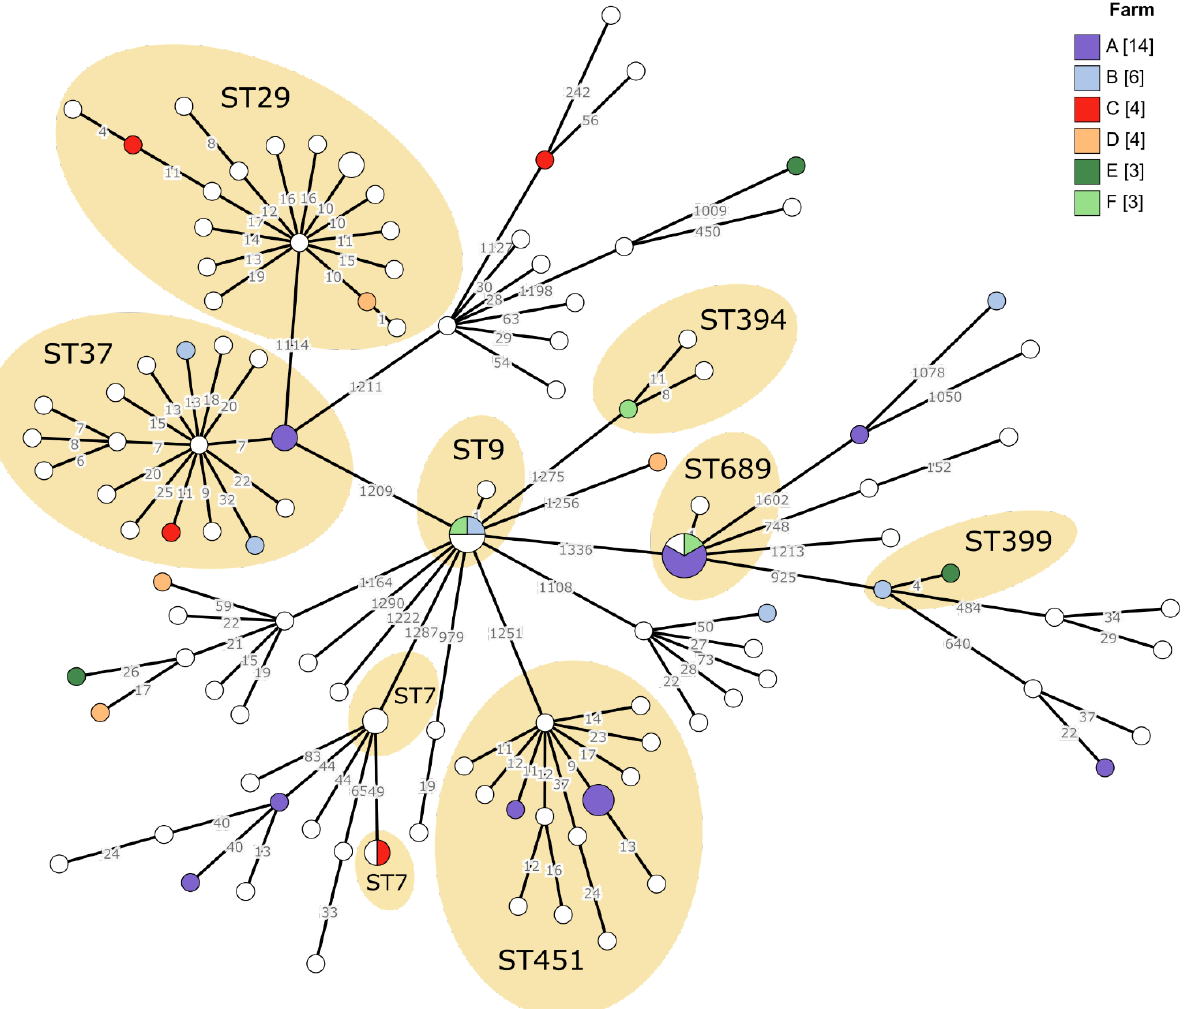
Figure 2. A minimum spanning tree showing the core genome allele diversity of L. monocytogenes isolates from cattle abortions. The tree is based on 1701 cgMLST loci. Farms with more than three isolates (designated as A–F) are represented with a color code, and the nod size is proportional to the isolate count per genotype. Depicted branch lengths are log- transformed but numbers on the branches represent the absolute distance between genotypes in the number of loci. The clusters within STs where the distance between a least two isolates is 10 alleles or less are highlighted as possible infection outbreak or transmission events.